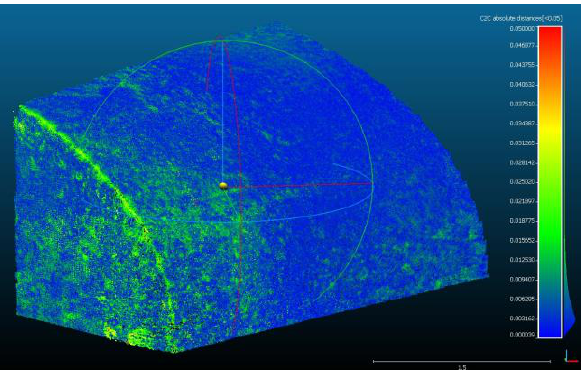
Figure 6. The discrepancy between the point cloud from 15 equirectangular projections and a laser scanning dataset used as reference. The error is about 5 mm. The object shown is a part of a vaulted cellar. Other comparisons confirmed this metric